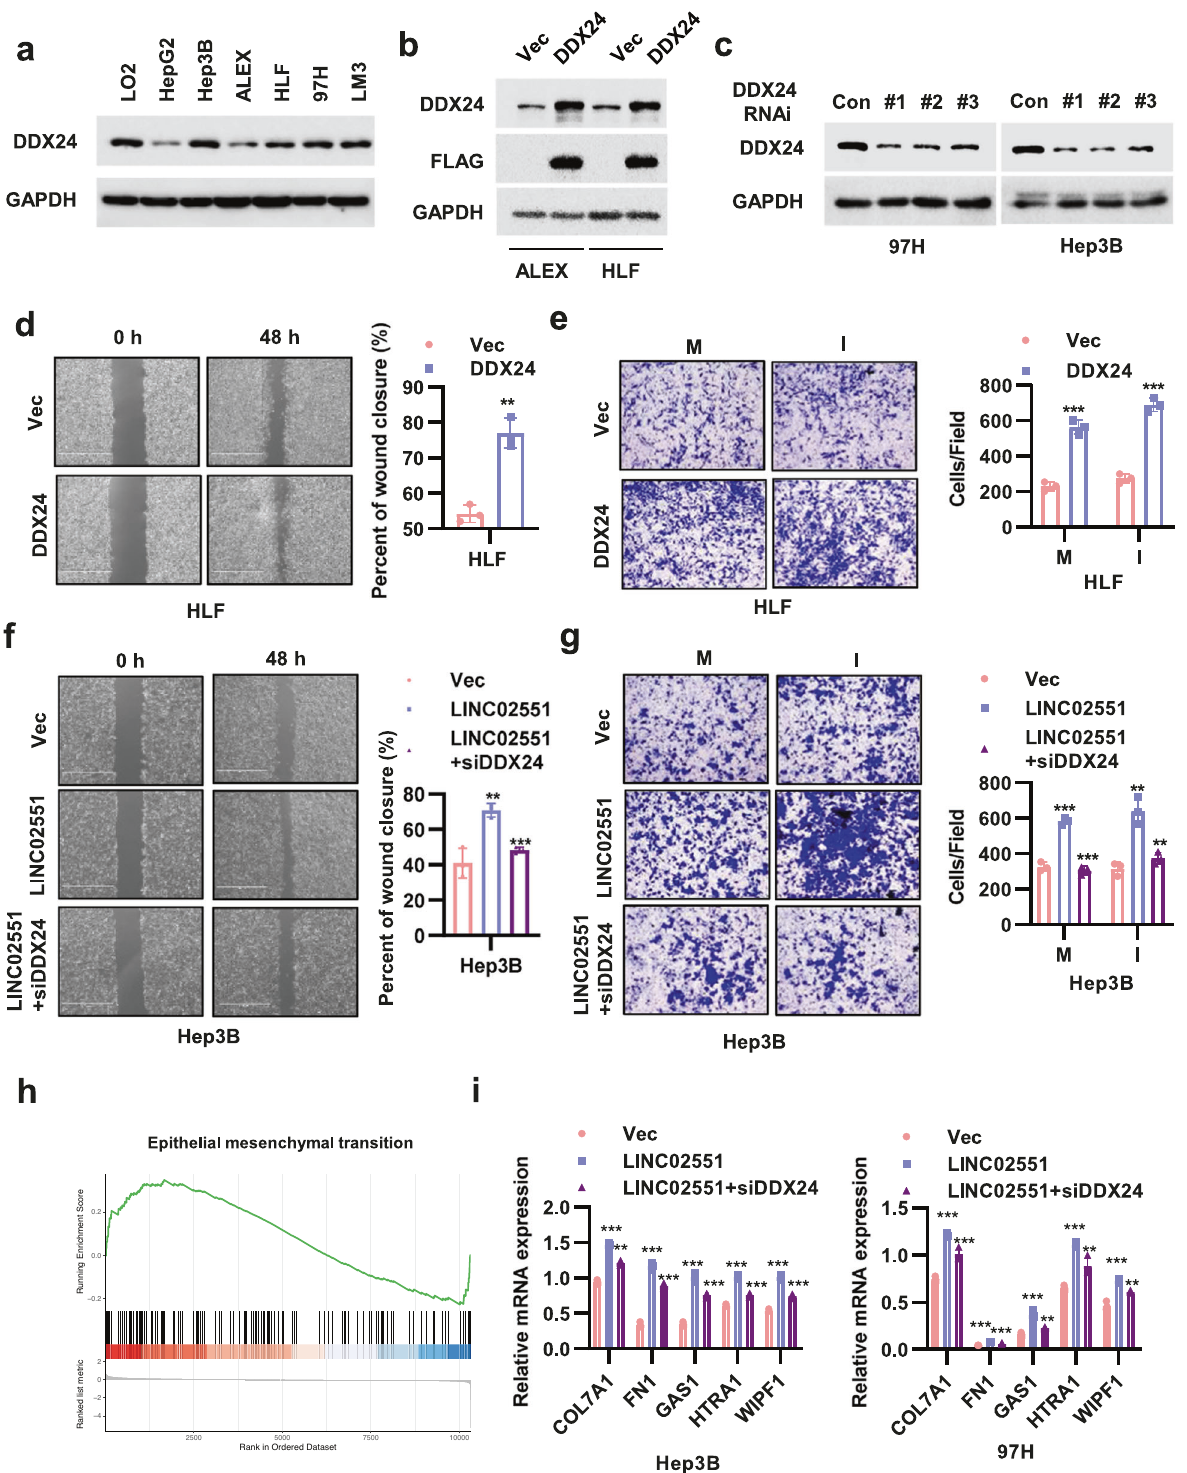
Fig. 6 LINC02551 exerts its effects by stabilizing DDX24 expression. a DDX24 protein levels were measured in HCC cell lines. b DDX24 expression in HLF and ALEX cells overexpressing LINC02551 . c DDX24 expression in Hep3B and 97H cells transfected with shRNA-induced LINC02551 knockdown. d The wound healing assay of HLF cells with DDX24 overexpression. e The migration and invasion results of HLF cells with DDX24 overexpression (M: migration; I: invasion). f The wound healing assay of Hep3B cells with LINC02551 overexpression with or without siDDX24. g The migration and invasion of the cells described in f. h Gene set enrichment analysis showed that epithelial mesenchymal transition-related genes identi fi ed by RNA-seq were signi fi cantly enriched in HLF cells with DDX24 overexpression compared with control HLF cells. i The top fi ve hit genes in EMT were selected to verify their expression in Hep3B and 97H cells with LINC02551 overexpression with or without siDDX24. Statistical analysis was performed using Student ’ s t -tests. Data are mean ± SEM. * P < 0.05, ** P < 0.001, *** P < 0.0001, ns, P >